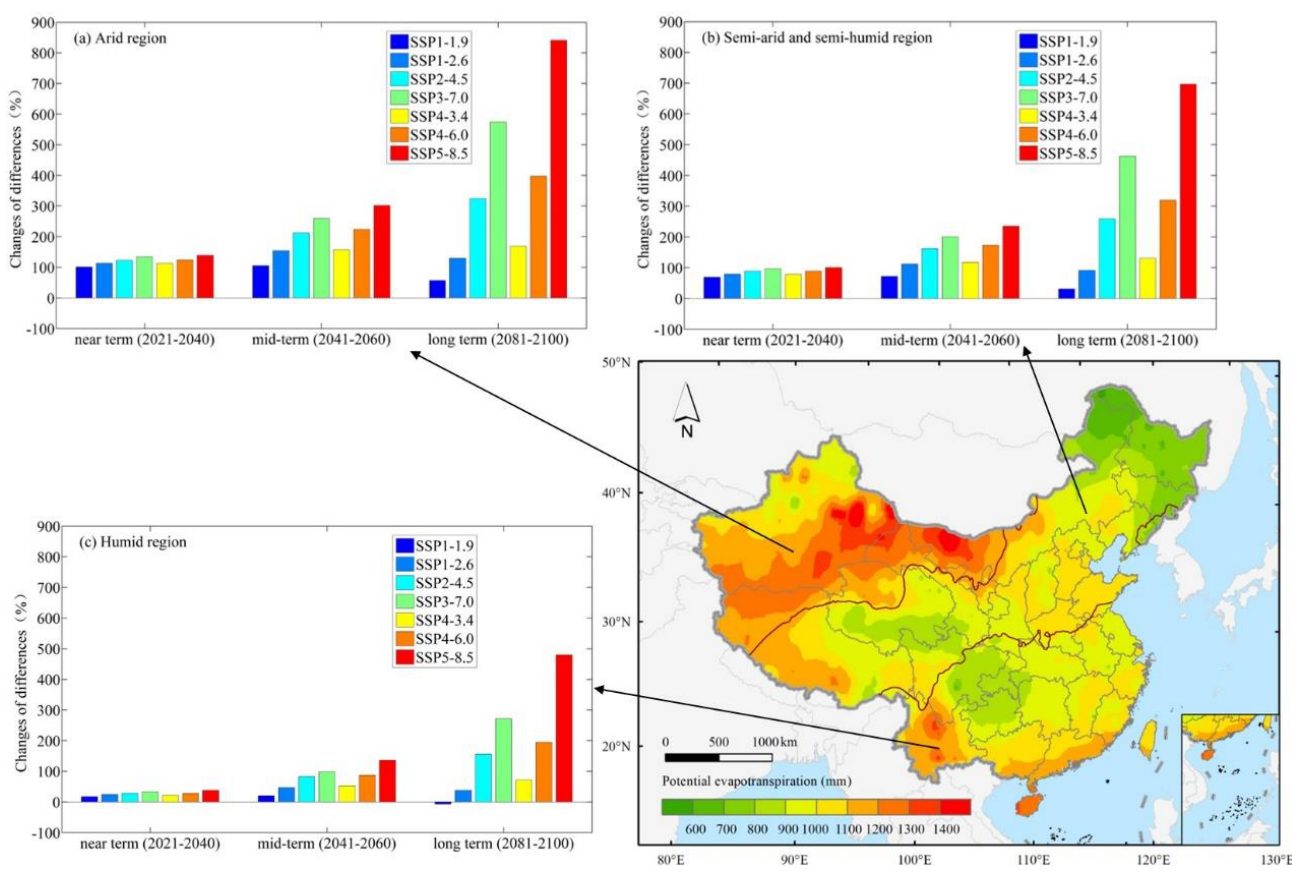
Figure 6. Spatial distribution of annual mean PET with CO 2 for 1961 – 2014 and its future change in the three climatic zones in China.